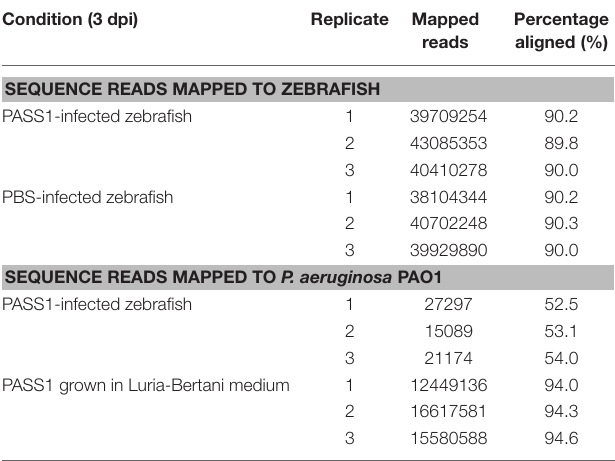
TABLE 1 | Summary of P. aeruginosa PASS1 and zebrafish embryos mapped reads at 3 days post-infection. Condition (3